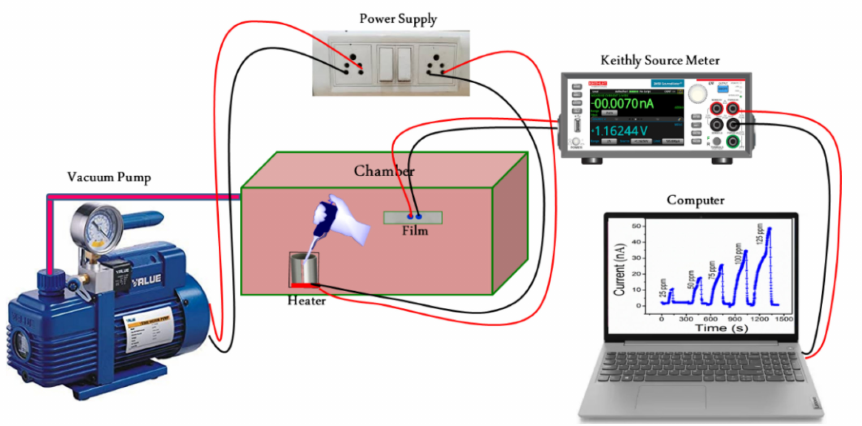
Figure 6. Schematic diagram of the ammonia gas sensing